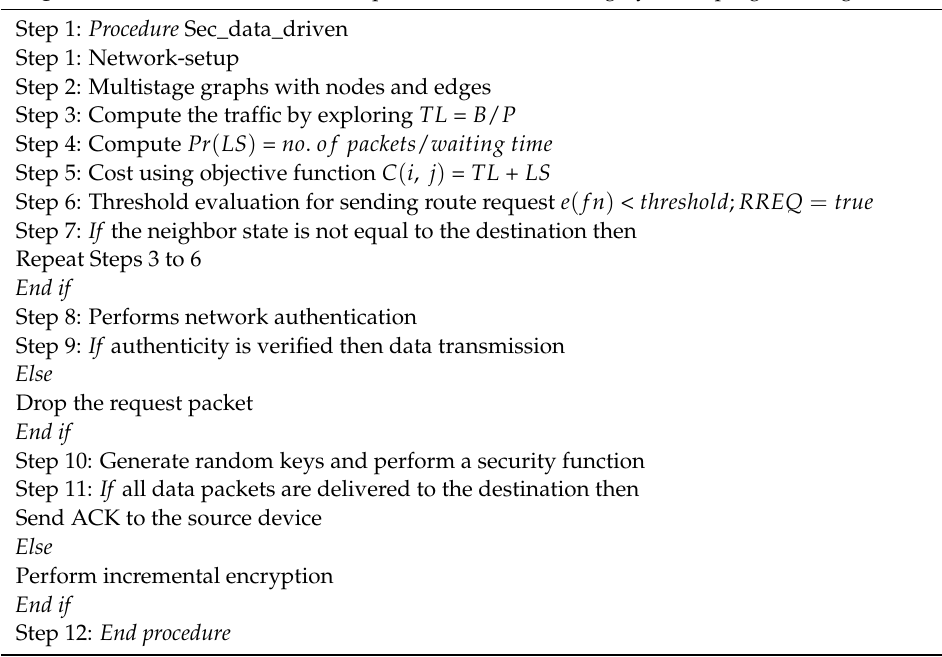
Algorithm 1 : Data-driven secured optimization model using dynamic